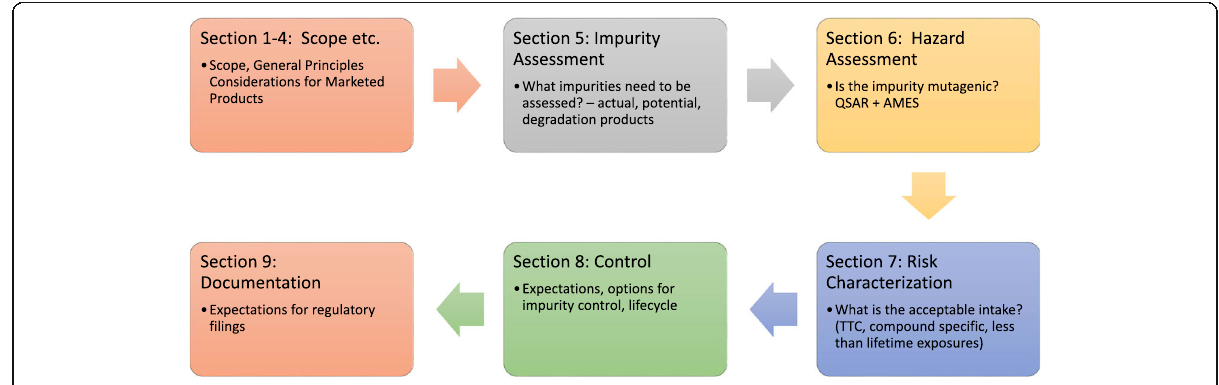
Fig. 2 Framework for M7